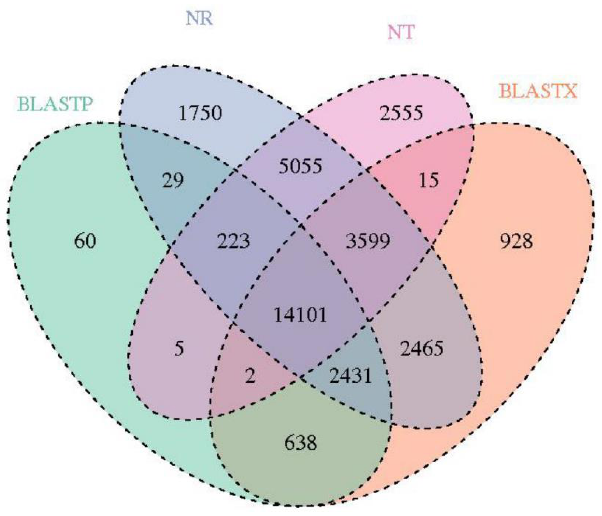
Figure 2. Venn diagram of the number of unigenes annotated by four protein databases.